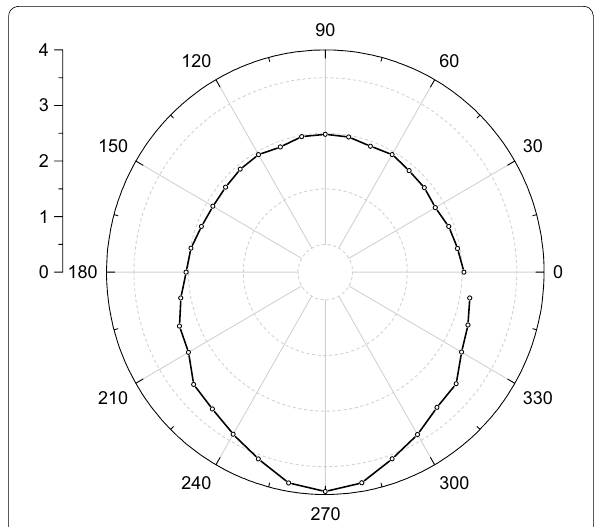
Figure 6 Directivity of sound wave for a single cylinder with phased array technique ( f = 850 kHz , and ka = 1.8 )